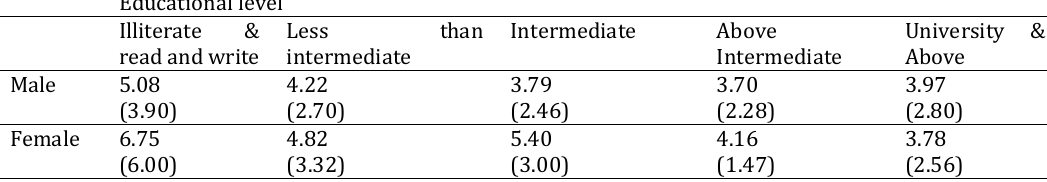
Table 4: Average unemployment duration by gender and level of education (years) Educational